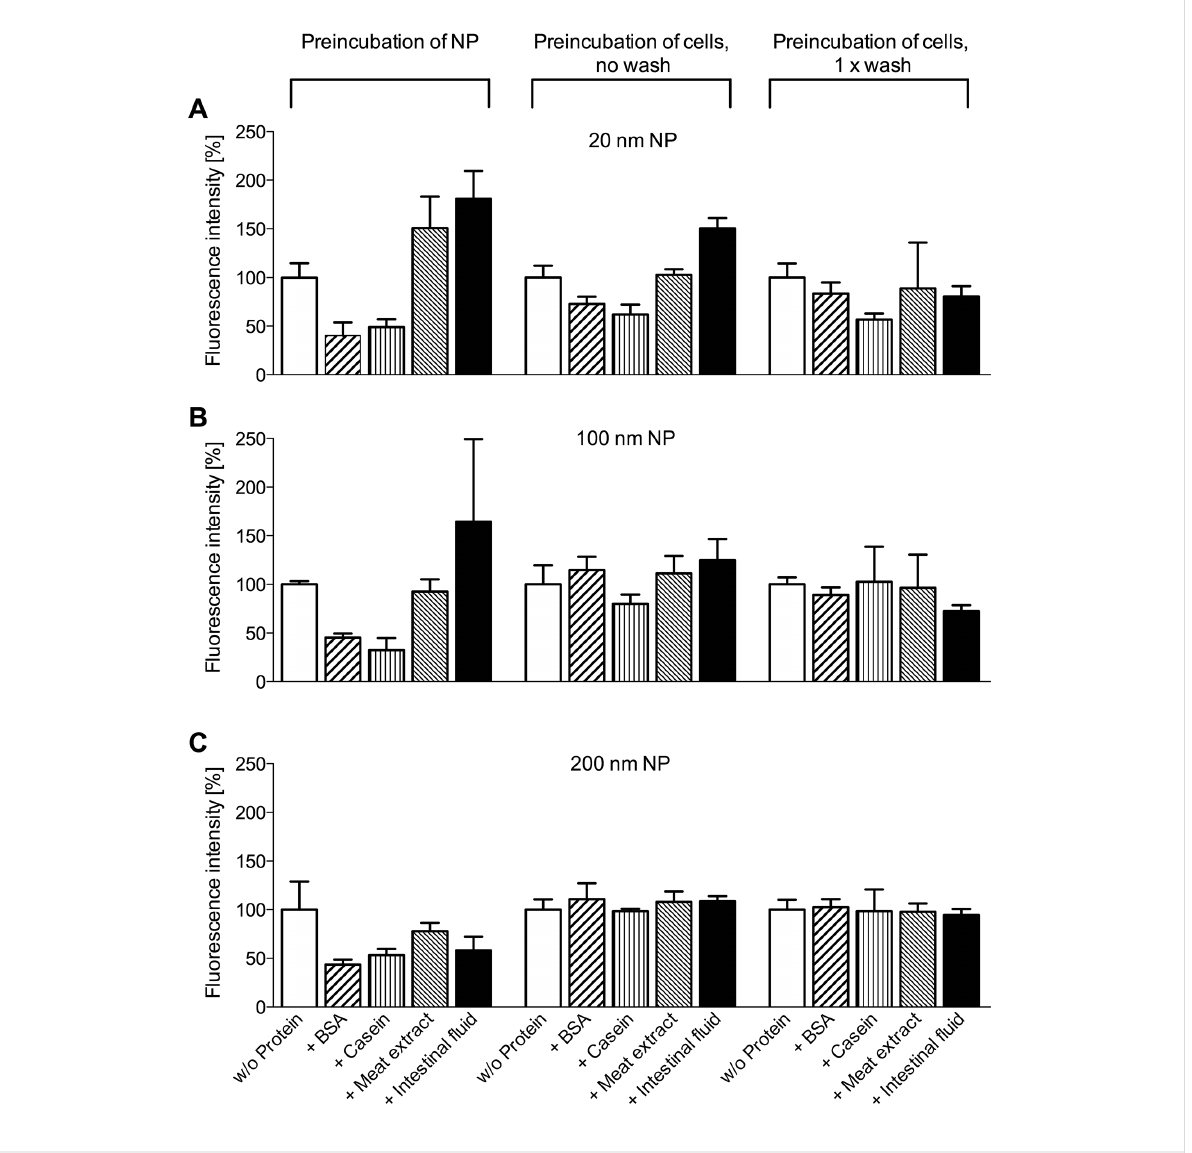
Figure 4: Interaction of fluorescent NPs with cells after preincubation with proteinaceous compounds. Either differently sized NPs or Caco-2 cells were preincubated with buffer or with different proteins before interacting with each other. Particle adherence to the cells was determined by fluores- cence microscopy. Values were normalized to intensities obtained with untreated cells and particles (mean + SD of three